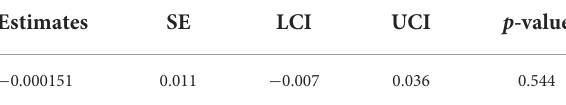
TABLE 3 MR-Egger intercept test results of the association between frailty index and vestibular